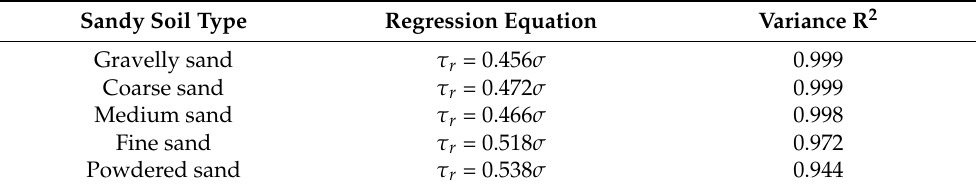
Table 4. Regression equation of residual strength and normal stress of